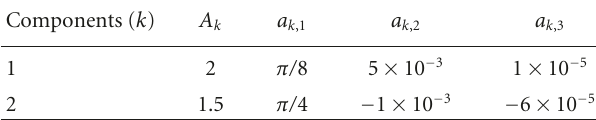
Table 1: Parameters of the simulated